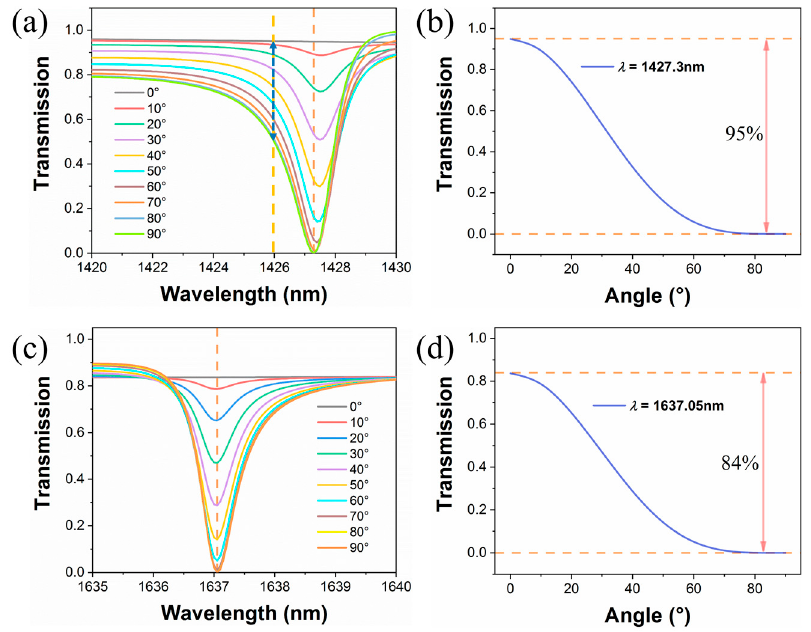
Figure 5. Transmission spectra for modes I ( a ) and II ( c ) with different incident polarization angles. The transmission intensity at wavelengths of 1427.3 nm ( b ) and 1637.05 nm ( d ) with continuously varying polarization angles.